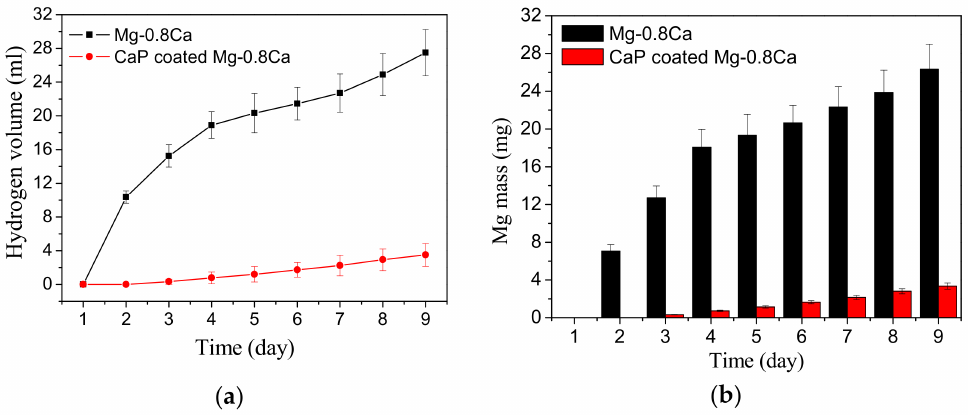
Figure 10. Volume of evolved hydrogen ( a ) and the mass of released magnesium into 0.9% NaCl solution ( b ) with